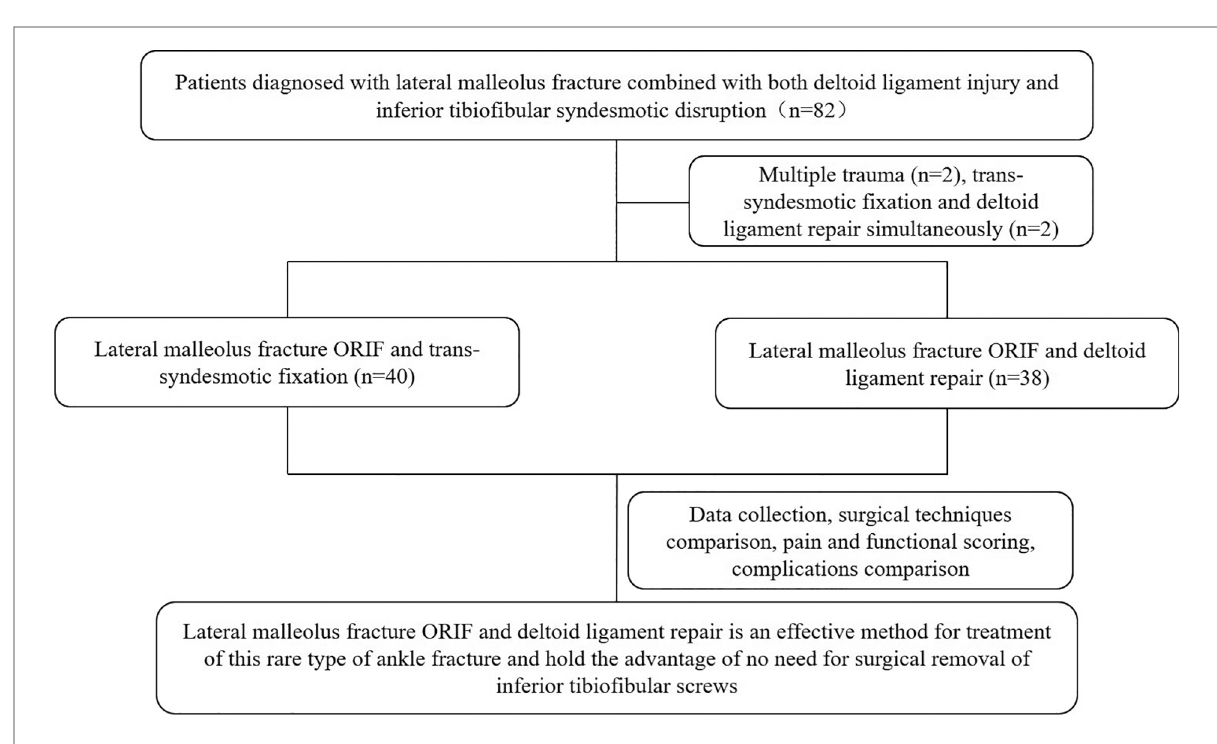
FIGURE 1 Flow chart for the study